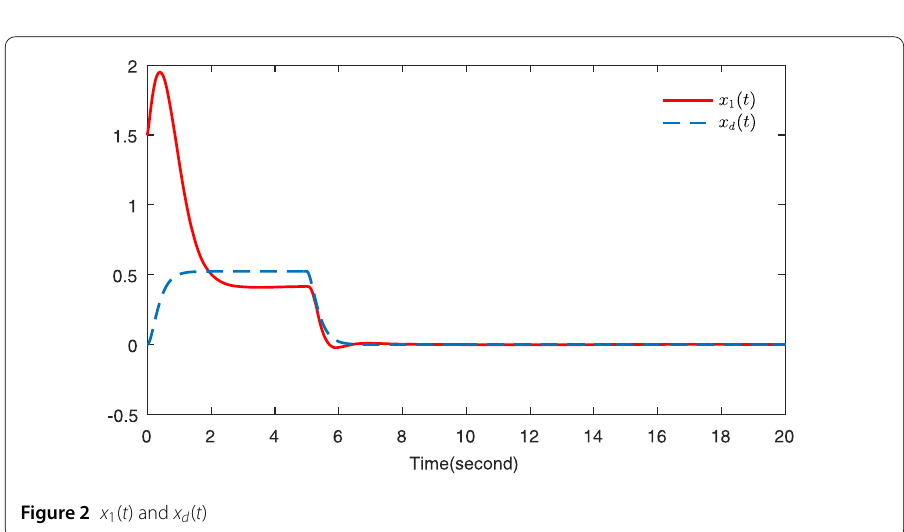
Figure 2 x 1 ( t ) and x d ( t )